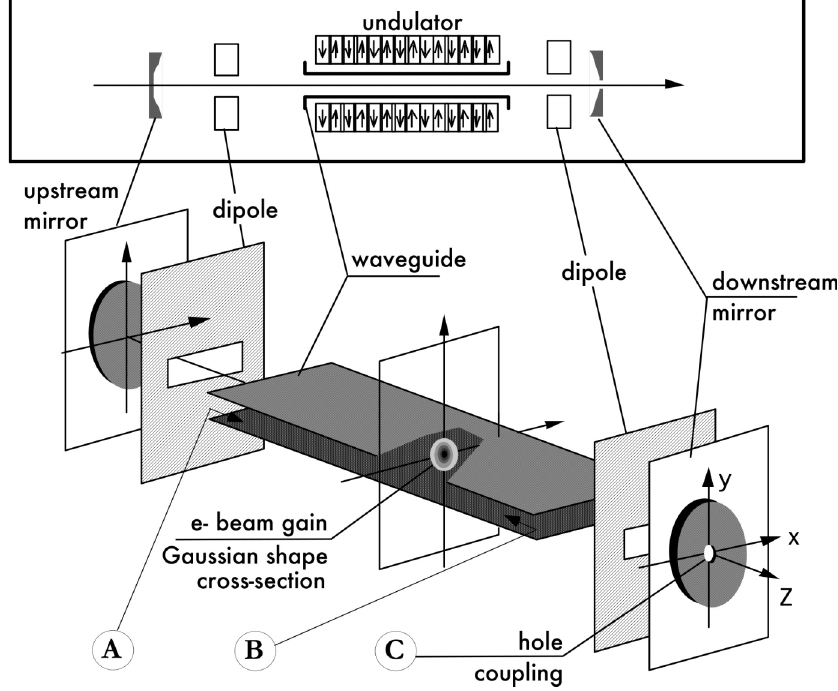
FIG. 1. Schematic layout of the CLIO free-electron laser optical